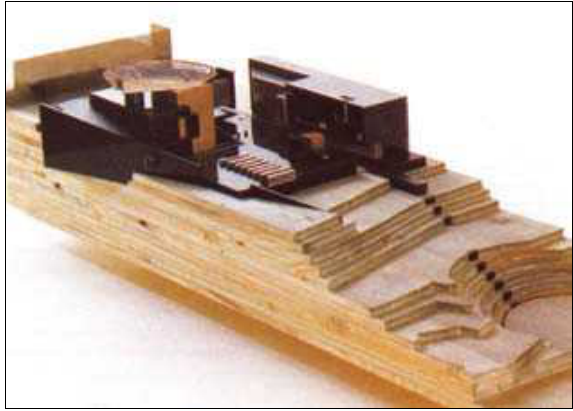
14 pav. komer­cinis pastatas Mindau­go g. Vilniu­je (ar­chit. G. ku­ginis, s­. Misevičiu­s). Maketas Fig. 14. commer­cial bu­ilding in Mindau­gas st in Vilniu­s. a­r­chitects G. ku­ginis, s­. Misevičiu­s.